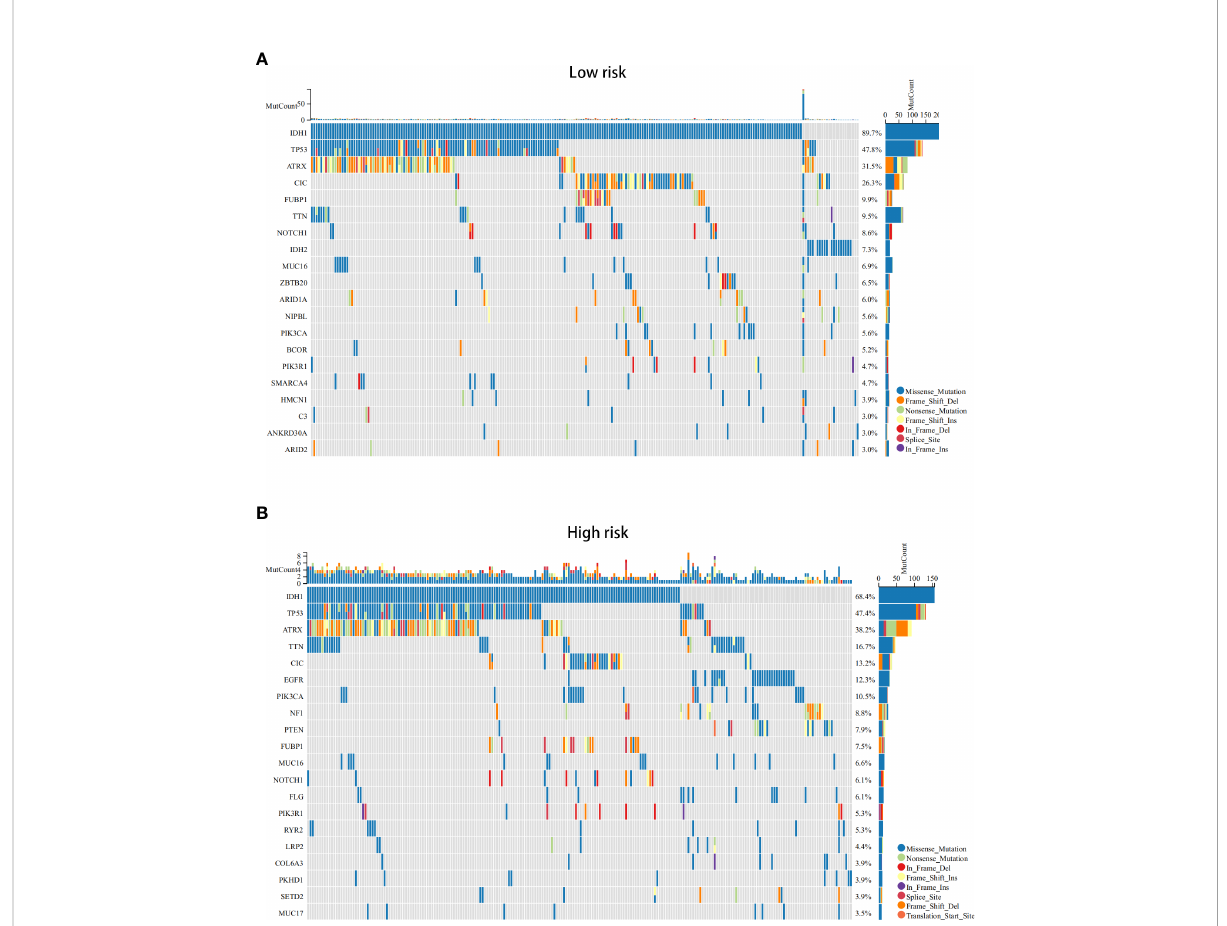
FIGURE 8 The somatic mutations in the ICD-high and ICD-low risk groups (obtained by LASSO Cox regression analysis). (A, B) The top 20 most frequently mutated genes in ICD-high risk groups (A) and ICD-low risk groups (B) were visualized in waterfall